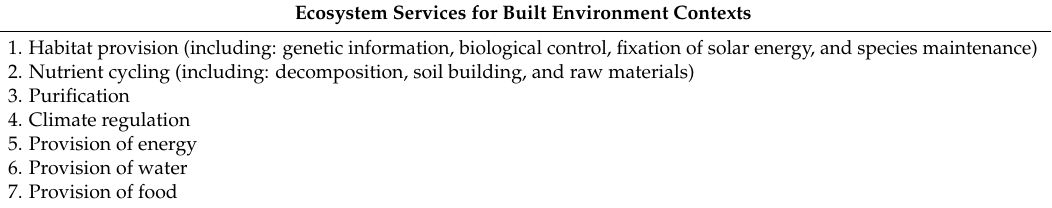
Table 1. Ecosystem Services for Built Environment